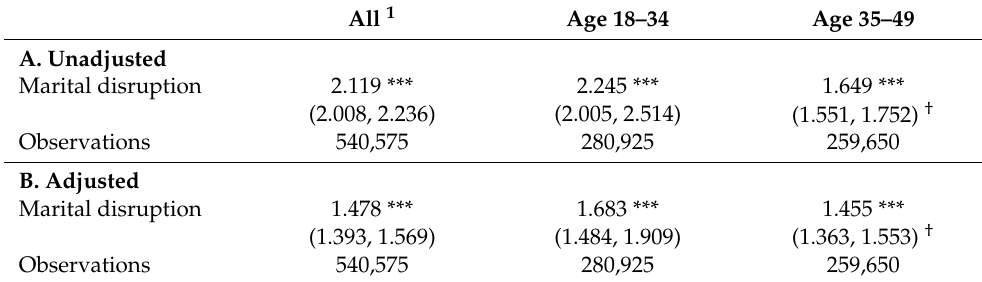
Table 4. Unadjusted and adjusted odds ratios in favor of tobacco use for marital disruption.